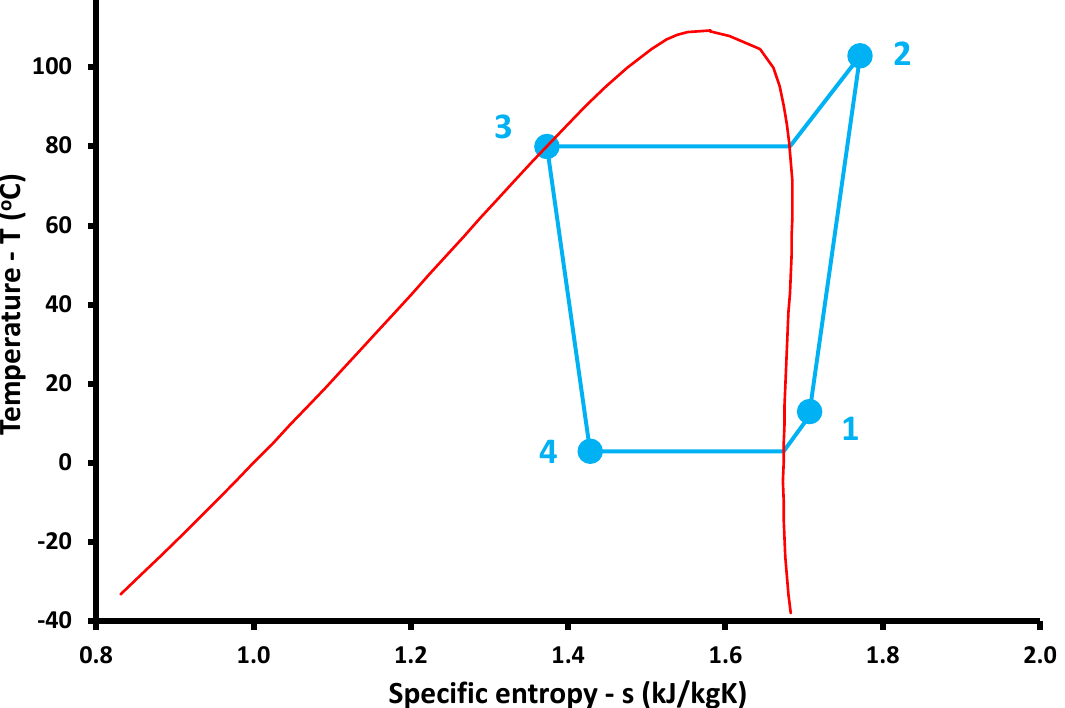
Figure 7. Temperature–specific entropy depiction (T–s) of the heat pump cycle for the case with ambient temperature at 10 °C.